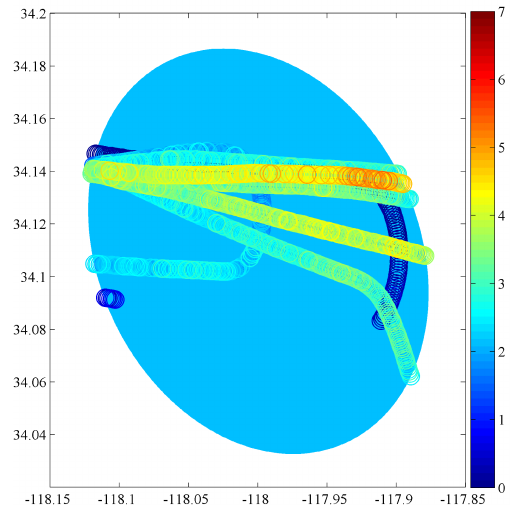
Figure 7. Spatial distribution of 1515 airborne observations made on-board the NOAA WP-3D aircraft at various altitudes superim- posed on the corresponding IASI footprint. The color scale cor- responds to the individual concentrations (ppbv) measured by the CIMS instrument, while the value for IASI is the average of the VMR calculated from the same total column at the different alti- tudes of the aircraft.